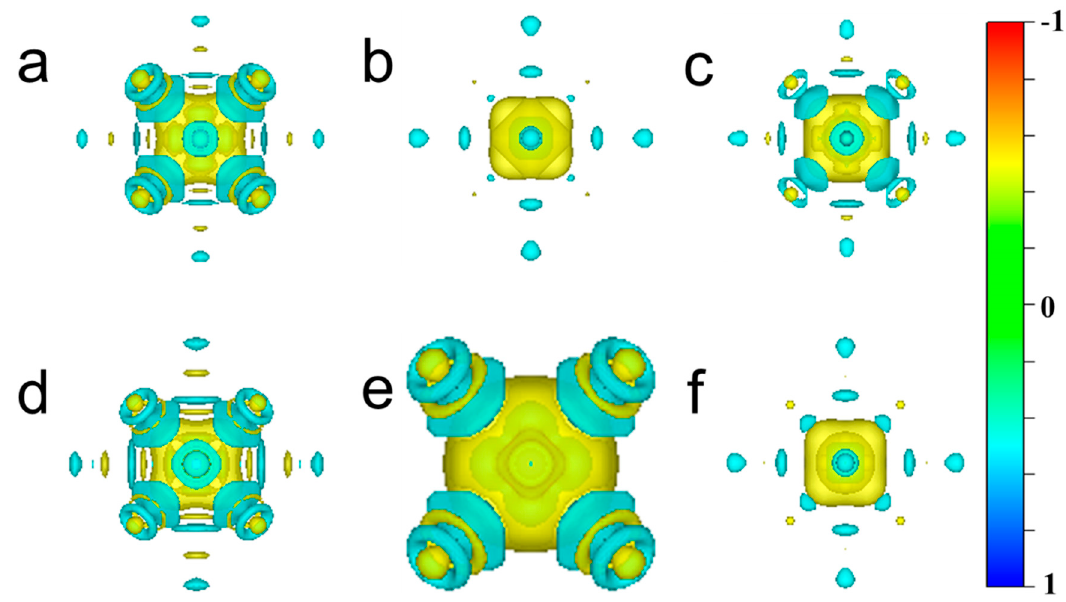
Figure 3. Charge transfer of the W-TM (TM = Cr, Cu, Fe, Mn, Mo and Ni, respectively) alloys. The color and size of W and TM impurities atoms are the same as in Figure 1. The yellow and blue color charge density contours indicate gain and loss charge, respectively. The value of all the isosurface levels is 0.00279115 e/Å 3 .